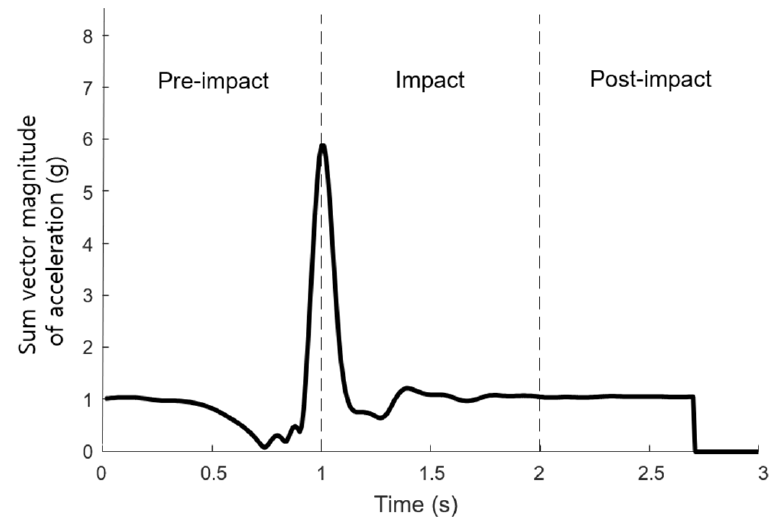
Figure 2. Stage of the impact by falls.